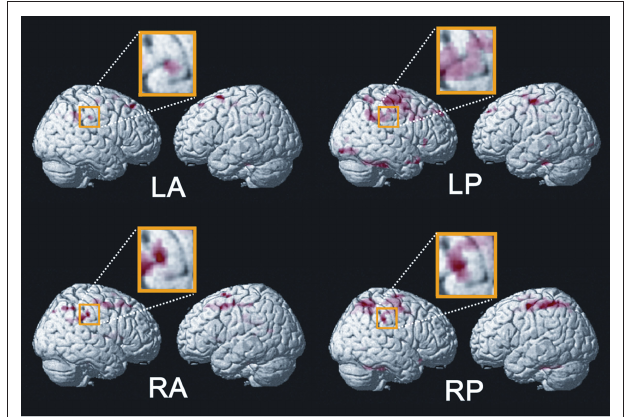
FIGuRE 8 | Neural activation in the anterior cingulate cortex (ACC) overlaid on an anatomically normalized MRI. Only LP and RP stimulation produced these activities. A brighter color represents a higher statistical significance. The threshold is P < 0.001 (uncorrected) in LP and P < 0.005 (uncorrected), respectively. Adopted from Sakamoto et al.